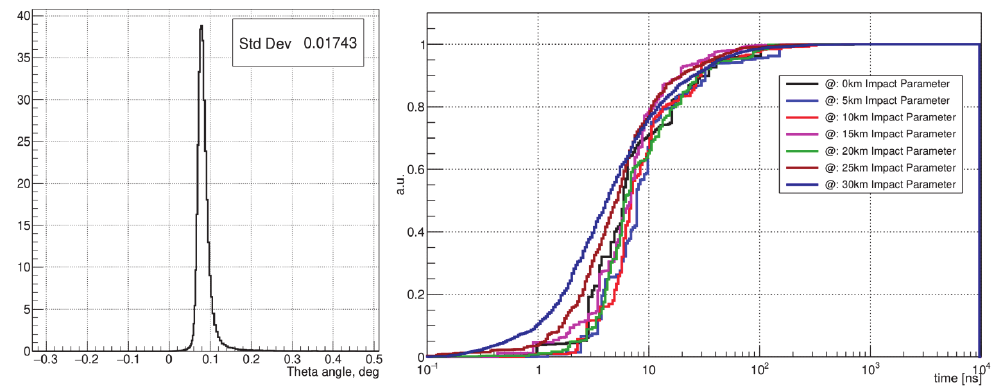
Figure 12: Left : Photon angle distribution for a proton of 100 PeV with respect to the shower axis seen by the telescope pointing in the direction of this axis. Right : Cumulative distribution of the Cherenkov photons as a function of time from the first one emitted in the direction of the telescope.